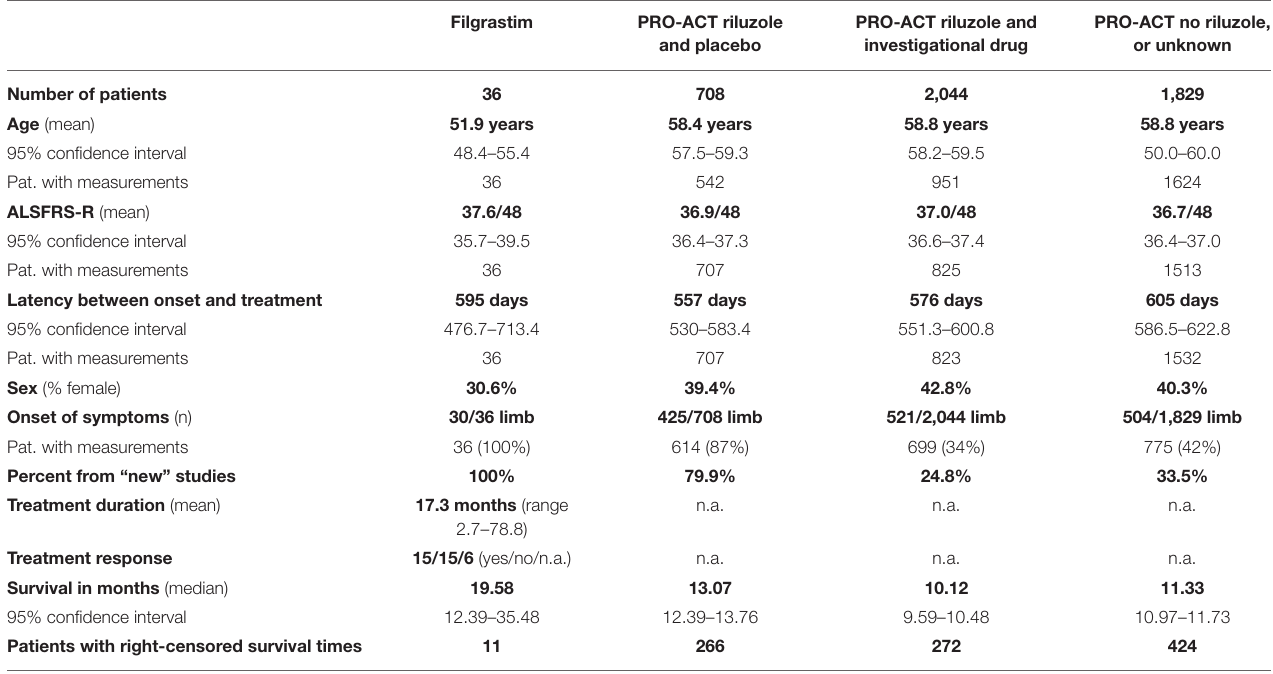
TABLE 1 | Baseline characteristics and key survival data of filgrastim-treated patients and the PRO-ACT subgroups.